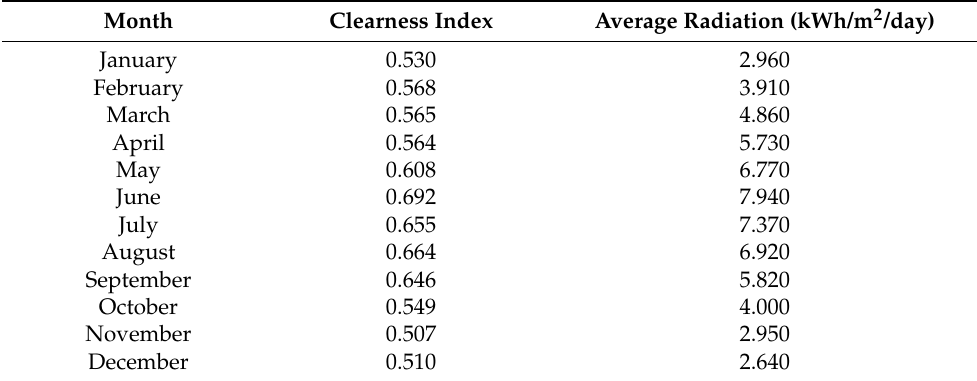
Table 3. Index of clarity and mean solar radiation.